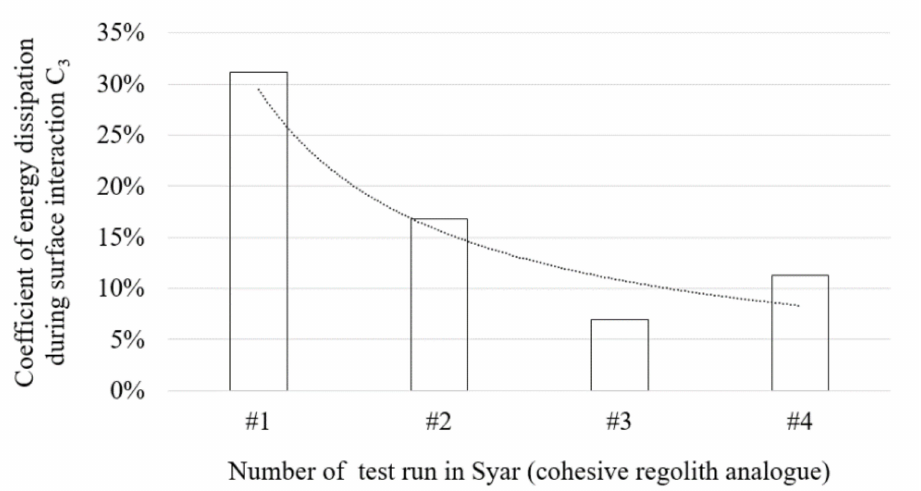
Figure 17. Results of the measurement of coefficient C 3 for subsequent jumps on Syar